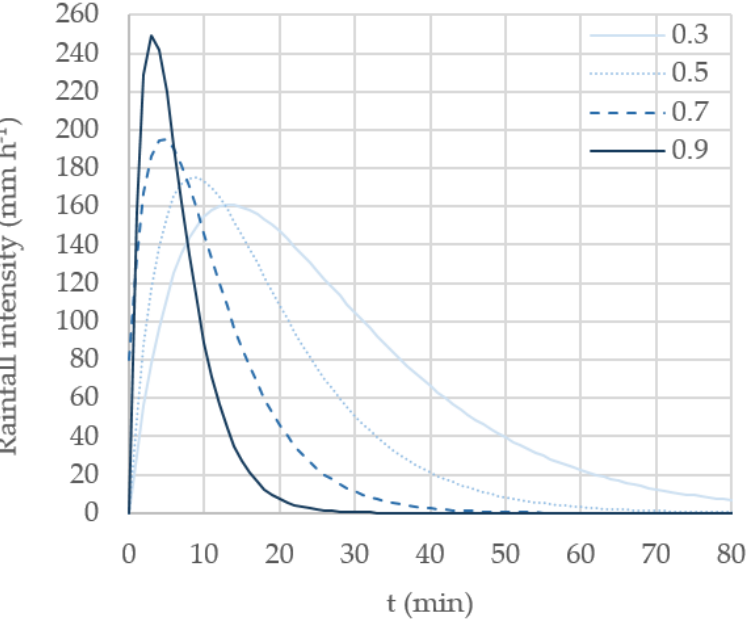
Figure 7. G2P design storms for T = 25 years in Valencia (Spain).